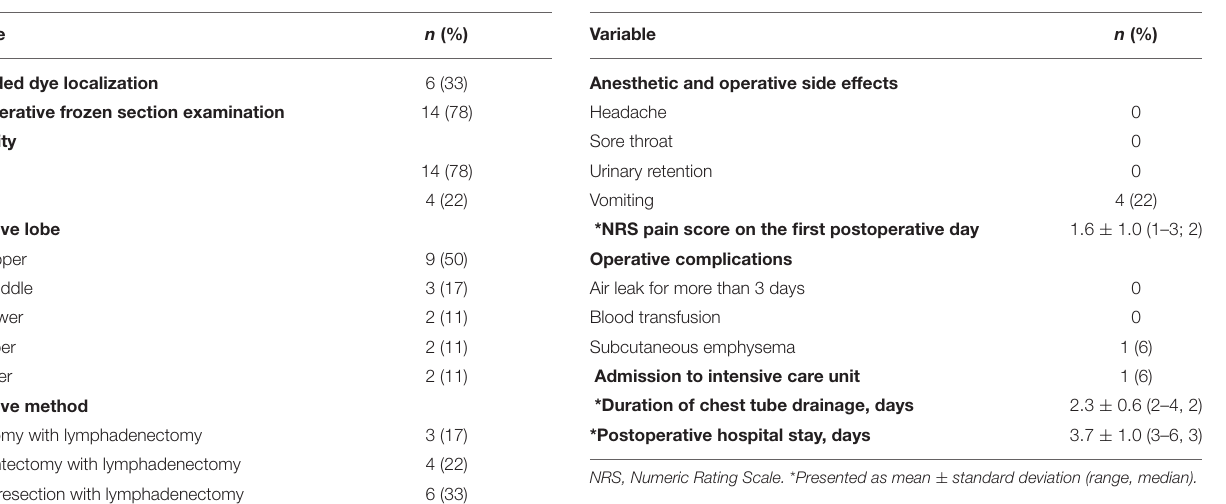
TABLE 2 | Anesthesia and intraoperative details. TABLE 3 | Postoperative